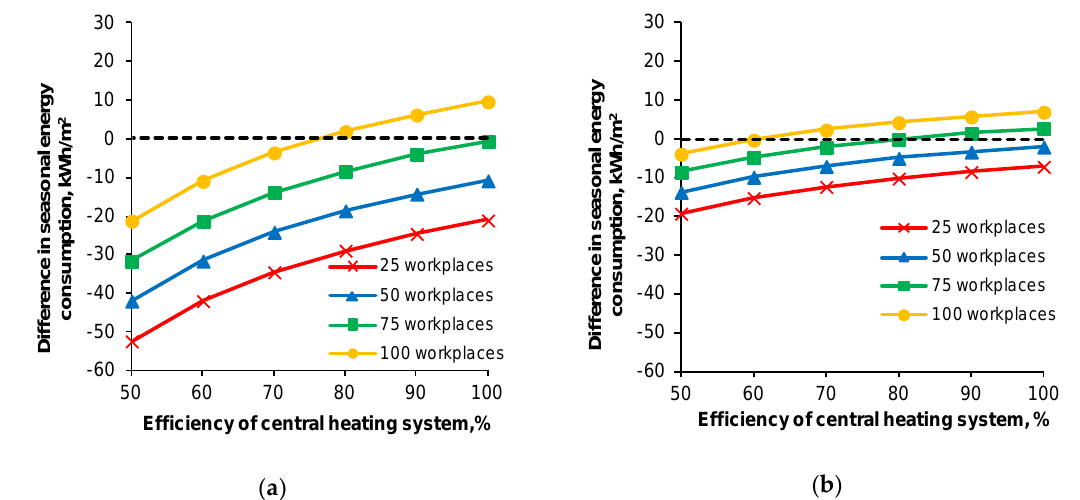
Figure 7. Difference in the seasonal additional energy consumption for workplaces heating from 16 °C to a comfort temperature with a local system in comparison to a central system for two internal heat gains variants: 10 ( a ) and 50 W/m 2 ( b ).